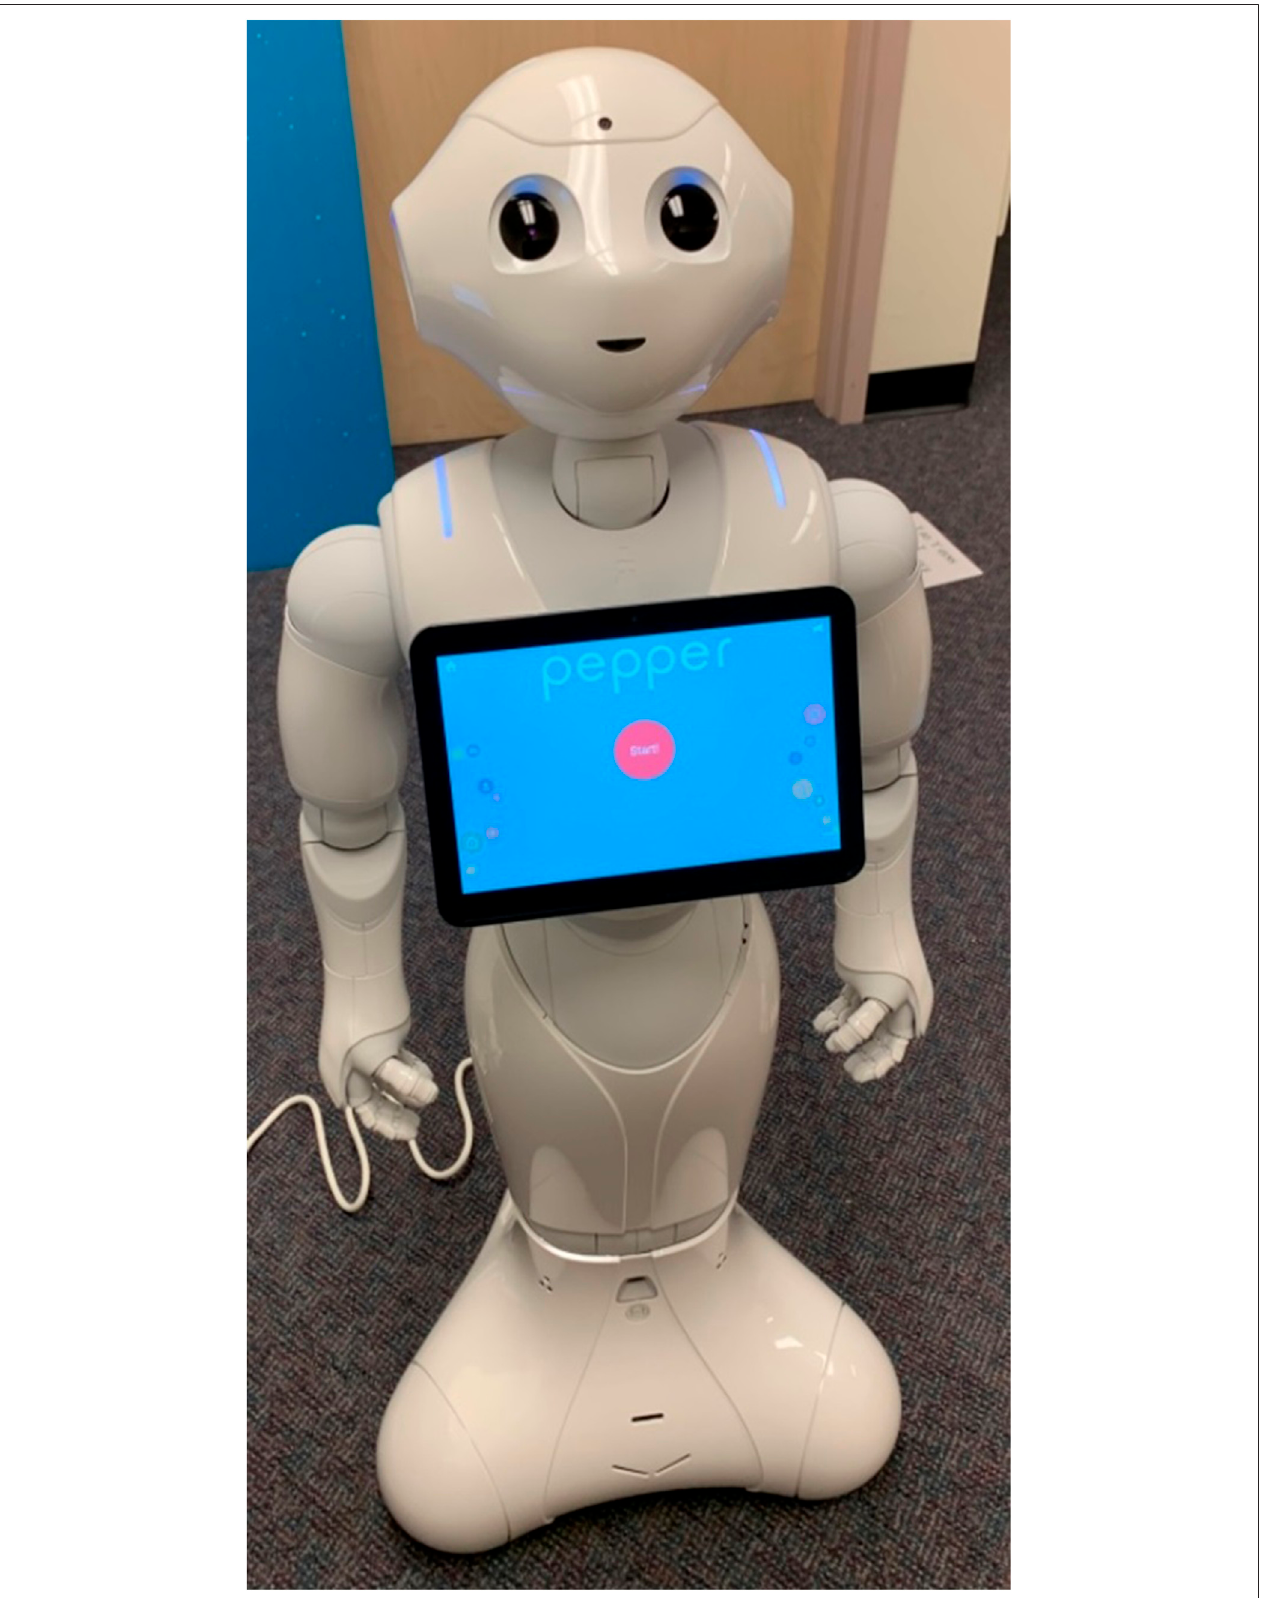
FIGURE 5 | A picture of Pepper the robot from Softbank Robotics.